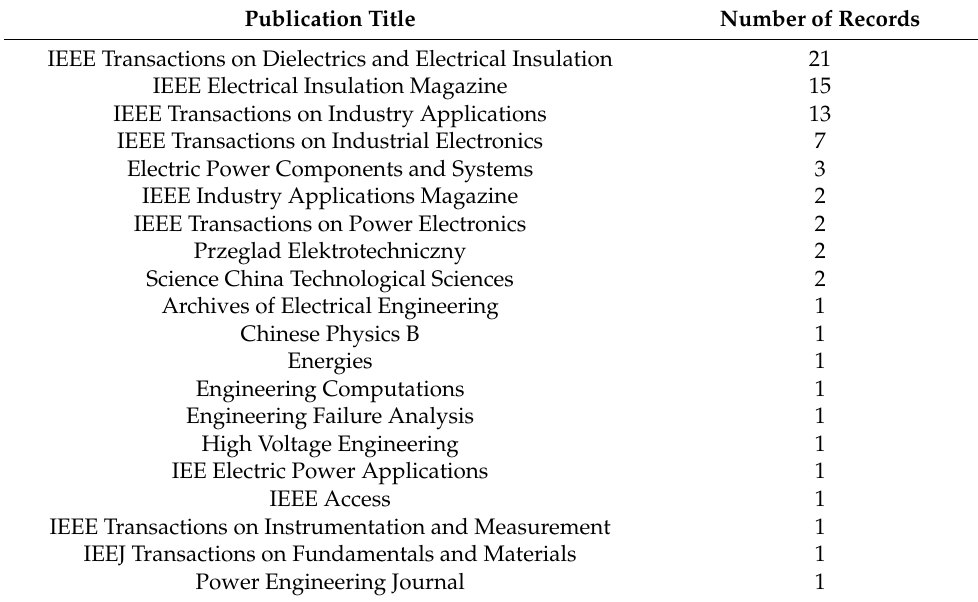
Table 3. Number of articles published in respective journals and magazines.